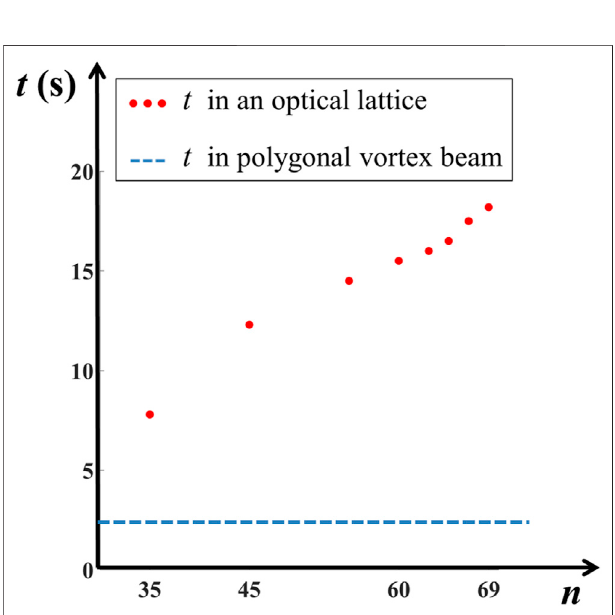
FIGURE7| Sortingtime(s)in theoptical lattice withdifferentnumbers of arrays n